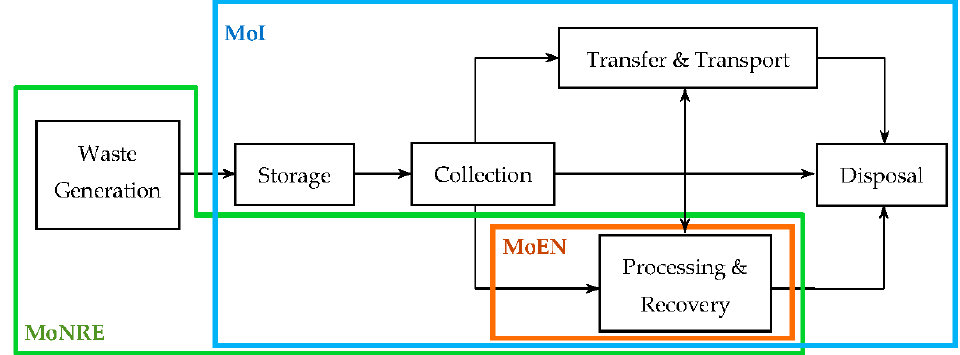
Figure 1. Scope of roles and responsibilities of different government organizations under functional elements in the solid waste management diagram.